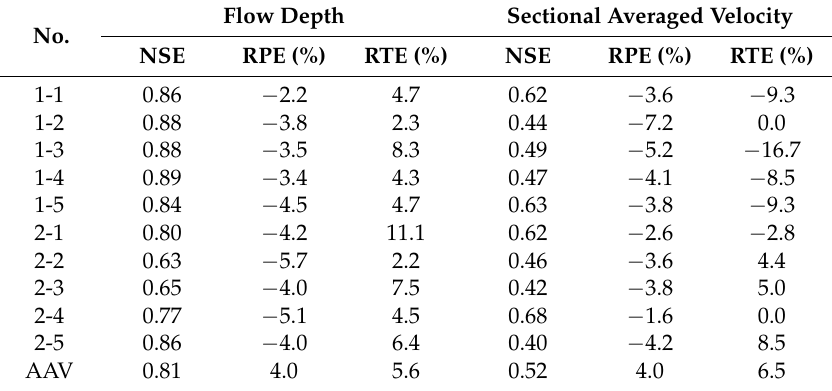
Table 4. The Nash–Sutcliffe model efficiency coefficients (NSEs), relative peak value errors (RPEs), and relative time-at-peak errors (RTEs) of the original SVN